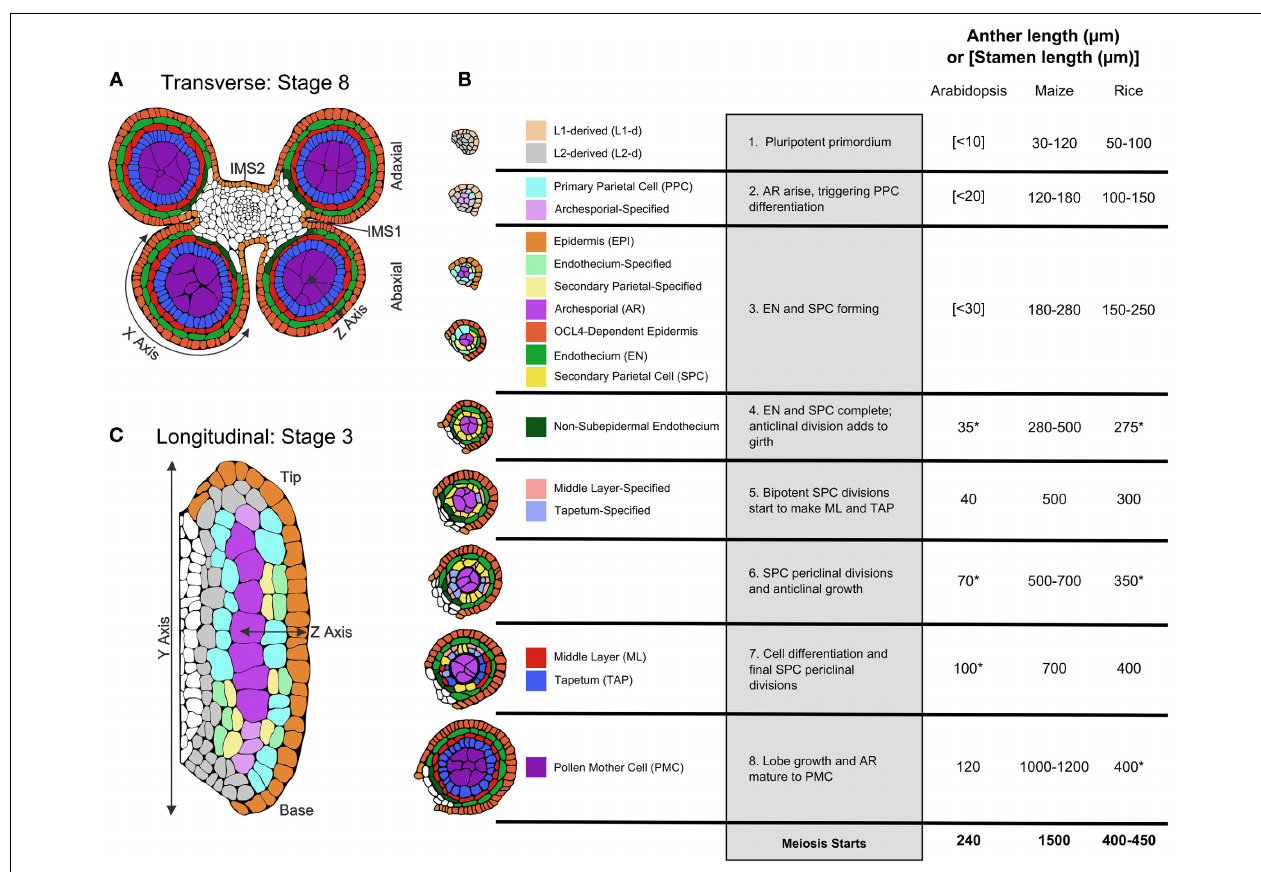
FIGURE 1 | Pre-meiotic anther development. (A) The four-lobed anther typical of flowering plants with a central column of vasculature that extends into the stamen filament surrounded by connective tissue [stage 8]. (B) Tracings of confocal images of single lobes of the W23 maize inbred are colorized to show the progression of cell fate specification and anther lobe patterning. At stage [1] the lobe consists of pluripotent Layer1- and Layer2-derived cells, colored in beige and light gray, respectively. For all cell types, just-specified cells are colorized in a pale shade, which gradually darkens as the cells acquire stereotyped differentiated shapes, volumes, and staining properties. The first specification event results in visible archesporial (AR) cells centrally within each lobe. In maize, the glutaredoxin encoded by Msca1 responds to growth-generated hypoxia to initiate AR differentiation, marked by secretion of the MAC1 protein, which is required for cell specification of the subepidermal L2-d cells to Primary Parietal Cells (PPC) [stage 2]. PPC divide periclinally generating the subepidermal Endothecium (EN) and the bipotent Secondary Parietal Cells (SPC). In the same timeframe, Epidermal (EPI) cells differentiate; signals controlled by expression of the OCL4 epidermal-specific transcription factor suppress excess periclinal